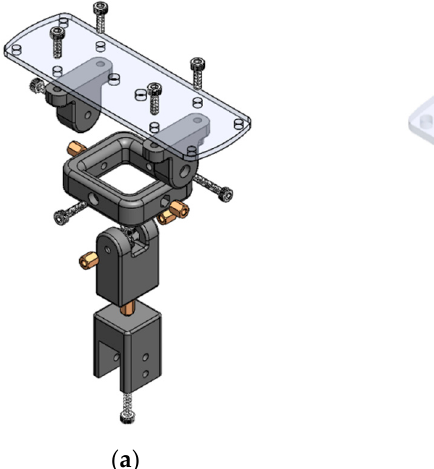
Figure 15. 3 DOF gimbal joint: ( a ) parts; ( b ) assembly.